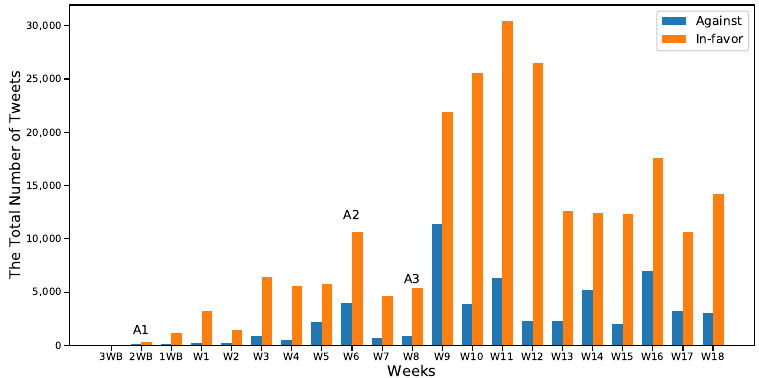
Figure 3. Distribution of cleaned tweets collected in the first